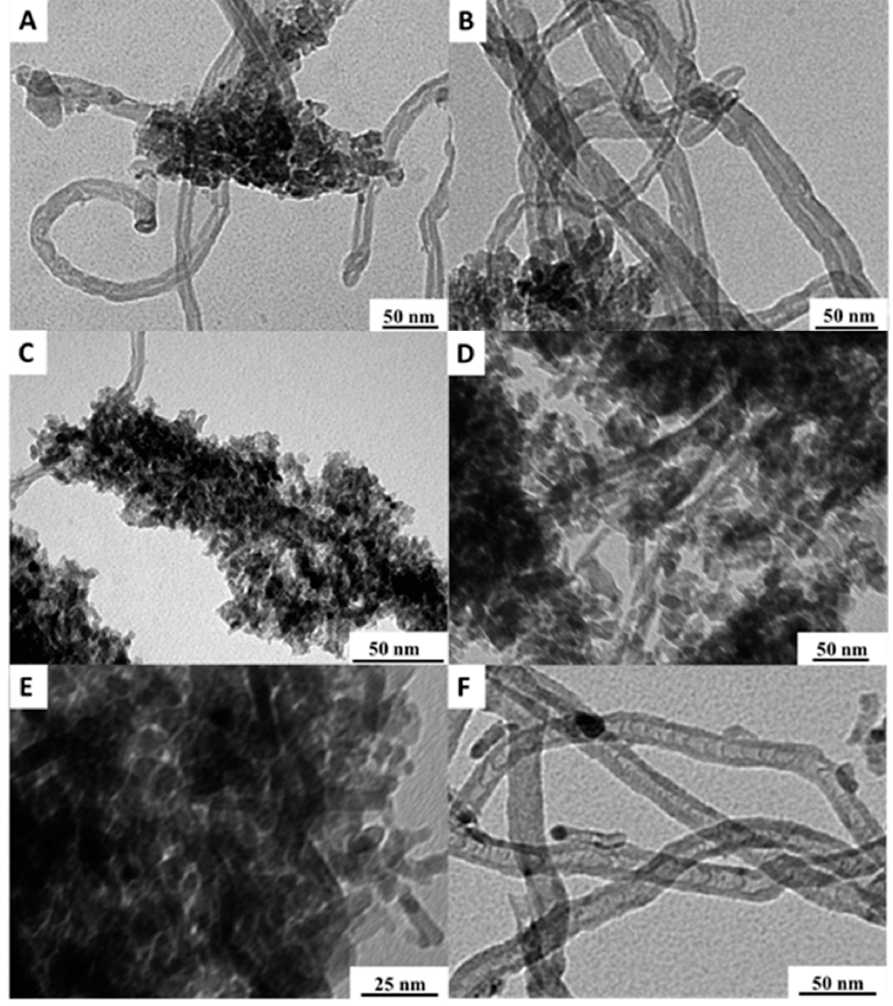
Figure 1. Transmission electron microscopy (TEM) images of selected catalysts after long run (at higher magnification): NiAl ( A ); NiAlCe ( B ); NiAlMg ( C ); NiAuAl ( D ); NiPtAl ( E ); NiAuPtAl ( F ) (reprinted with permission from Ref. [18], copyright 2014